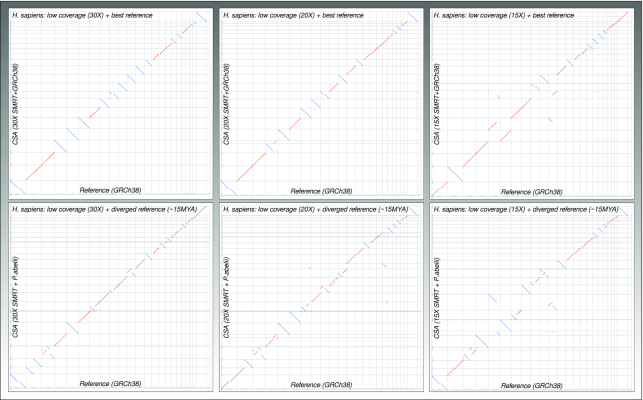
Dot plots of CSA results against reference genome for reduced coverage data (Homo sapiens), using either the best reference or a diverged reference to support CSA. For explanation of the dot plot properties, see Fig. 2.